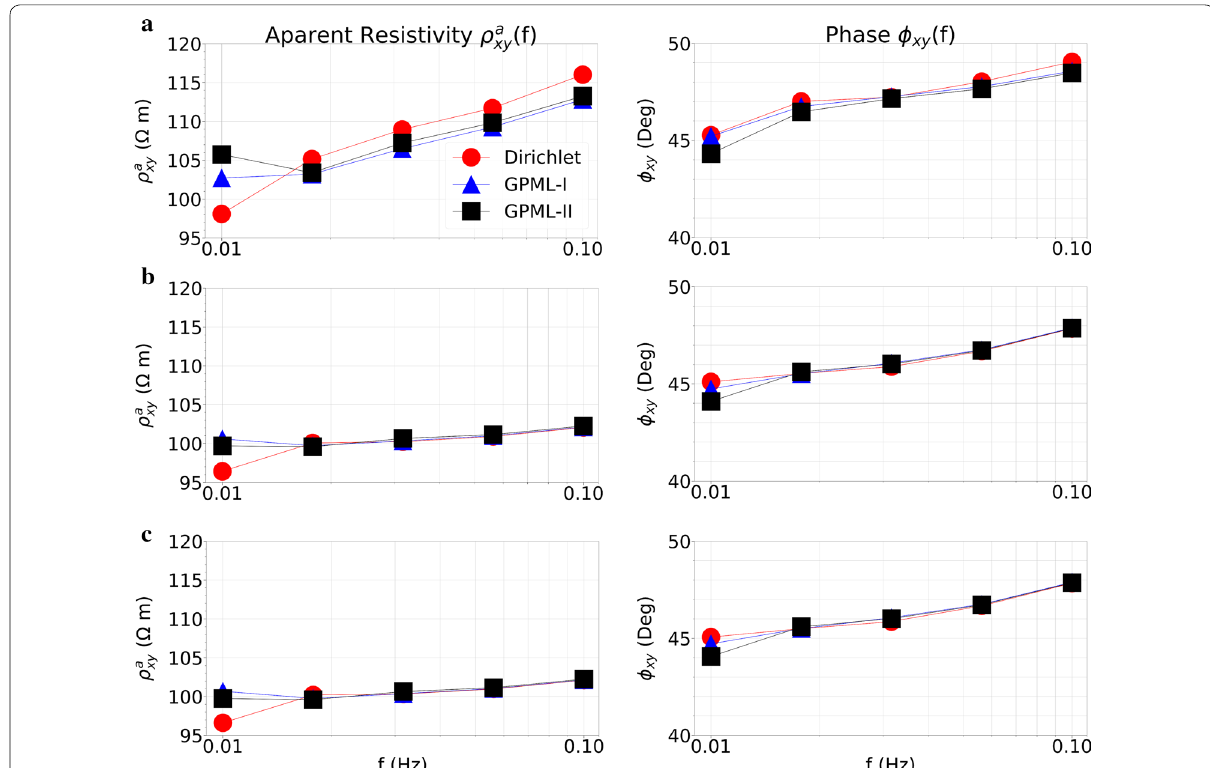
Fig. 6 MT responses over frequency range. Apparent resistivity (left) and phase angles (right) at the center point of the model surface, dependent on the signal frequency. Results are shown for all implemented boundary conditions, and for the following element orders: a linear elements, b quadratic elements, and c Lagrangian